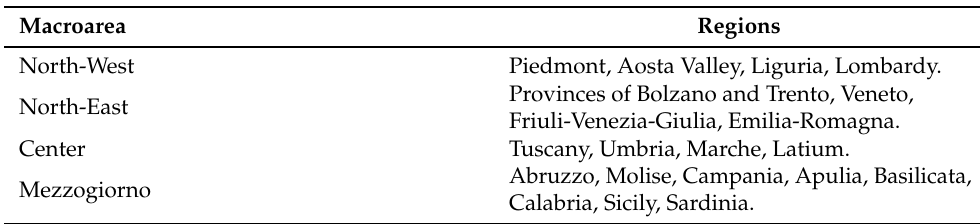
Table 2. Classification and composition of Italian macroareas (NUTS-1 level) and corresponding regions. Source: Eurostat.